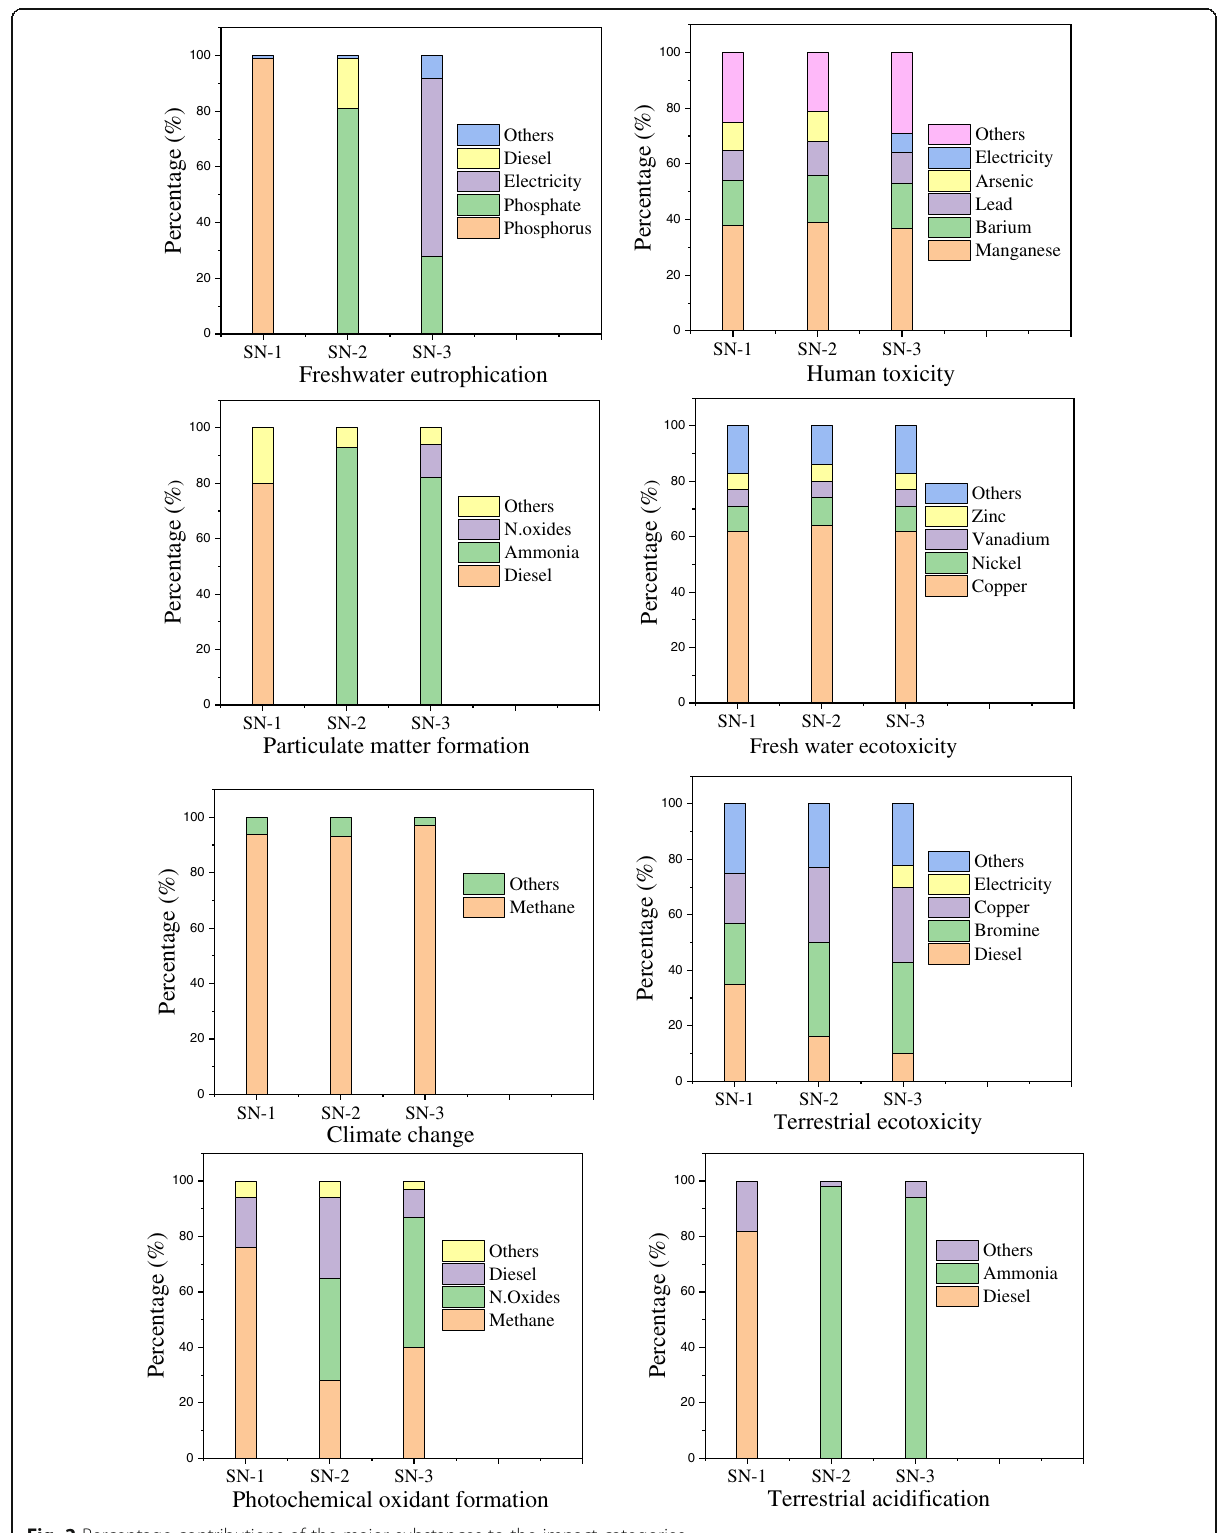
Fig. 2 Percentage contributions of the major substances to the impact